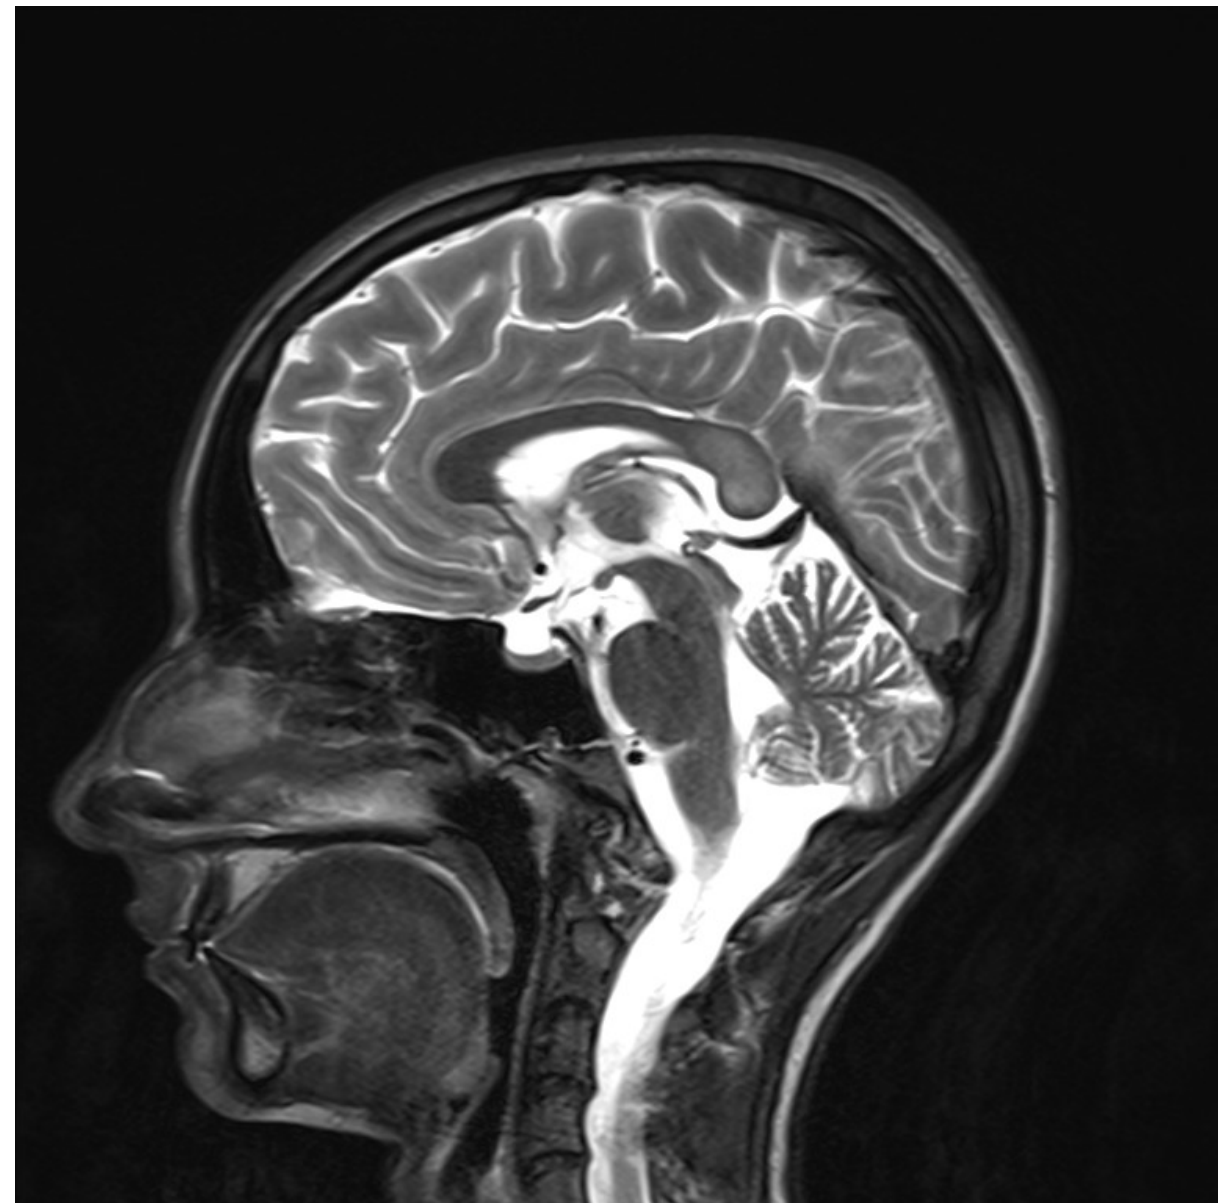
Figure 2. T2-weighted MRI sagittal view showing signal hyperintensity within the splenium of the corpus callosum.